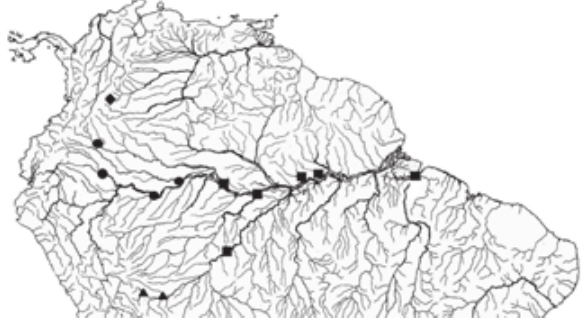
Fig. 7. Distribution map for species of Tyttocharax: T. cochui (  ), T. madeirae (  ), T. tambopatensis (  ) and T. metae (  ). Modified from Weitzman & Ortega